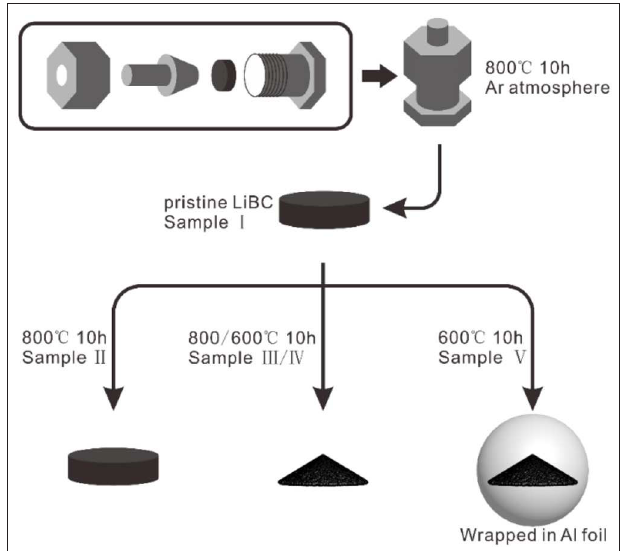
FIGURE 1 | Schematic diagram of LiBC synthesis within a stainless steel vessel and high-temperature treatment for pristine